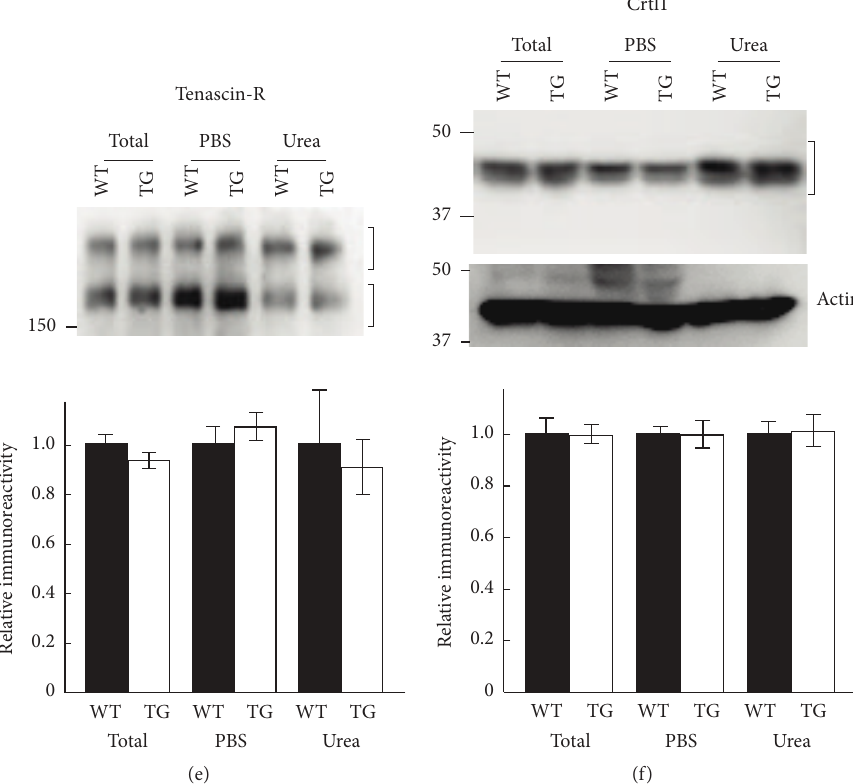
Figure 2: Sequential extraction of PNN components from adult mouse brain. Six-month-old adult WT and C6ST-1 TG mouse brain was sequentially extracted as described in Section 2. The same protein amount of the extracts was analyzed and intensities of the indicated bands were determined as relative values to WT mice for each extract. (a) The total level of aggrecan in C6ST-1 TG mice was significantly decreased compared with WT mice. Aggrecan levels in both the PBS extract and 6M urea extract slightly reduced in C6ST-1 TG mice although this did not reach statistically significant difference. The levels of neurocan (b), phosphacan (c), brevican (d), tenascin-R (e), and Crtl1 (f) were not different between WT and C6ST-1 TG mice. Actin was detected as loading control. Asterisks denote significant differences ( 𝑃 < 0.05 , Student’s t -test) between WT and C6ST-1 TG mice. Error bars represent SEM; 𝑛 = 3 for each